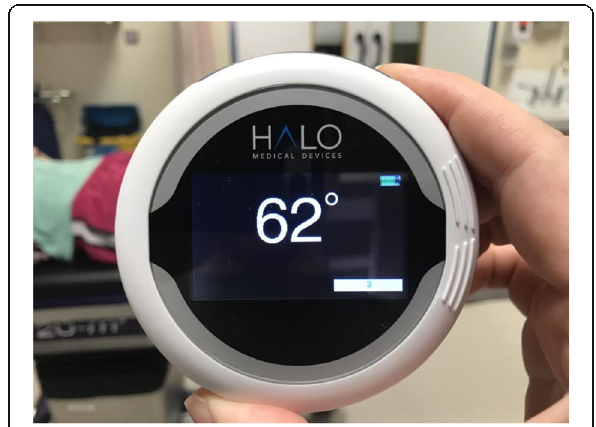
Fig. 5 Reading provided after measurement by Halo Digital Goniometer